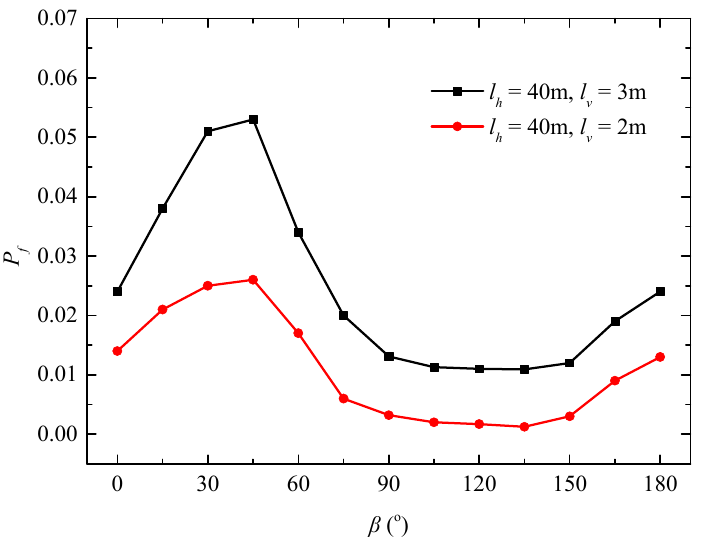
Figure 14. Failure probability with different autocorrelation lengths and random field rotation angles. It was found that the failure probability was decreased with a decrease in autocorre- lation length. This is because a higher autocorrelation length indicates that the soil shear strength is more strongly correlated, which can result in a relatively low variation. There- fore, the global average of the strength parameter changes a lot for different realizations, which results in higher variability of the obtained safety factors. Conversely, a small auto- correlation length can lead to more non-homogeneous zones, and smaller system response variation. It can also be interpreted by Figure 15 that the PDF of l v = 2 m was narrower than in the case of l v = 3 m, which showed a smaller variability. With increasing l v , the PDF curve approached the PDF obtained using the random variables (infinite autocorrelation length), which had the most significant variation, and the failure probability was up to 0.103.